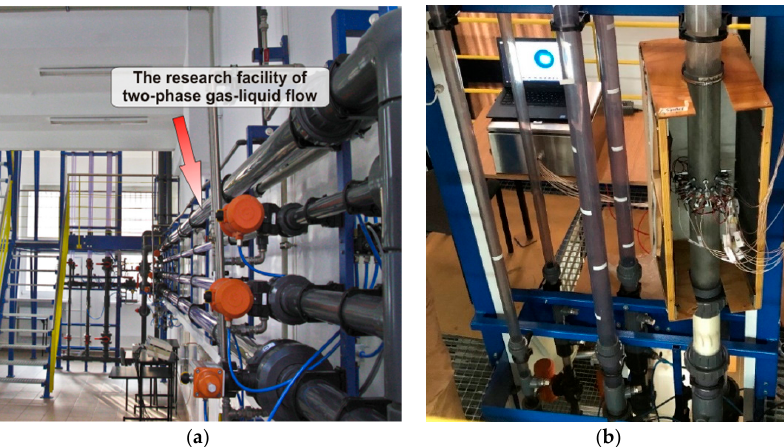
Figure 3. ( a ) Tom Dyakowski Process Tomography Laboratory horizontal and vertical liquid/gas Flow loop ( b ) Vertical flow installation with swirl element and ERT sensor mounted on the 90 mm pipe